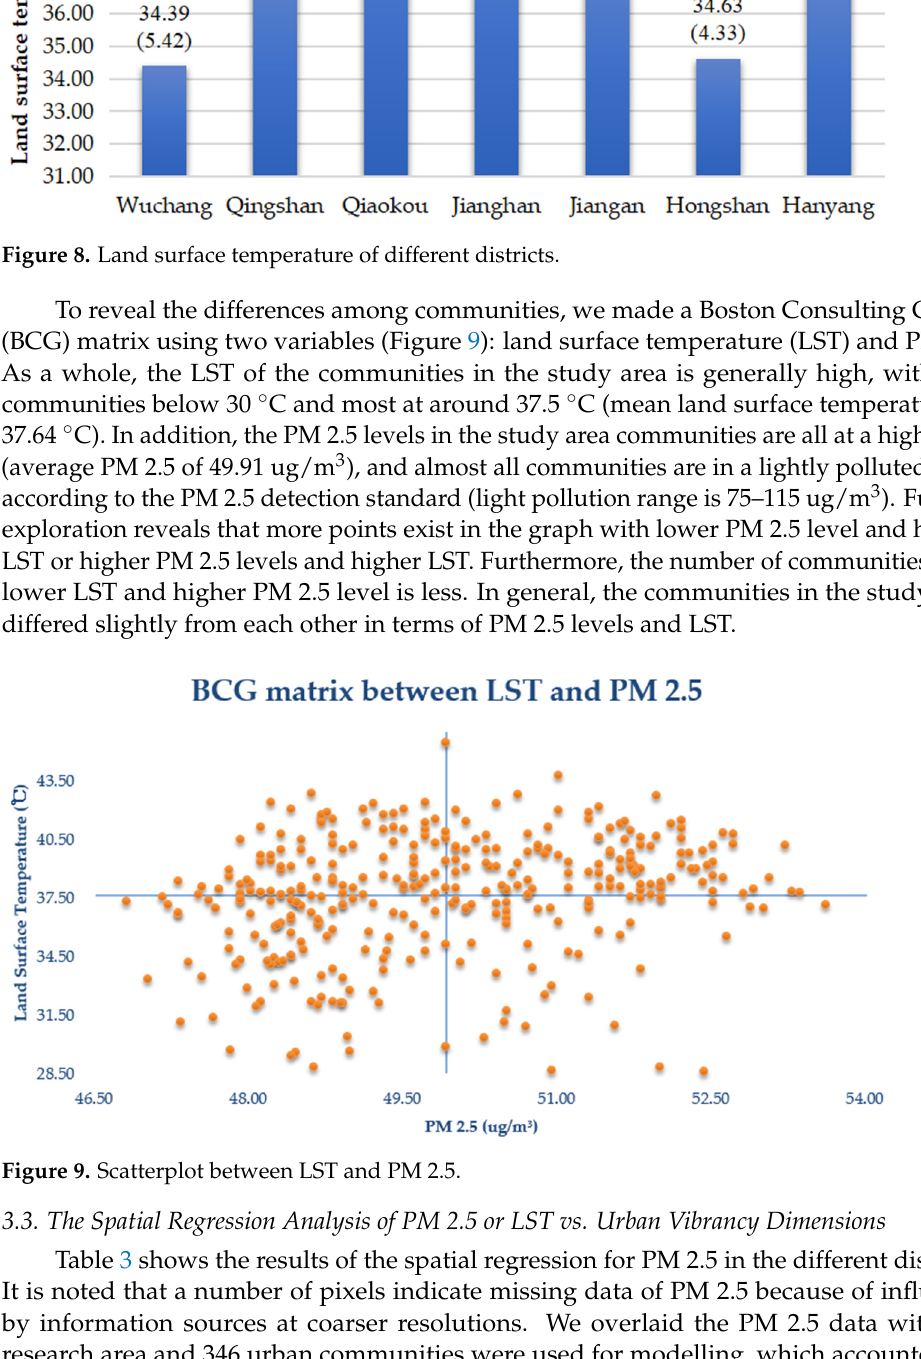
Figure 7. Spatial distribution of LST.